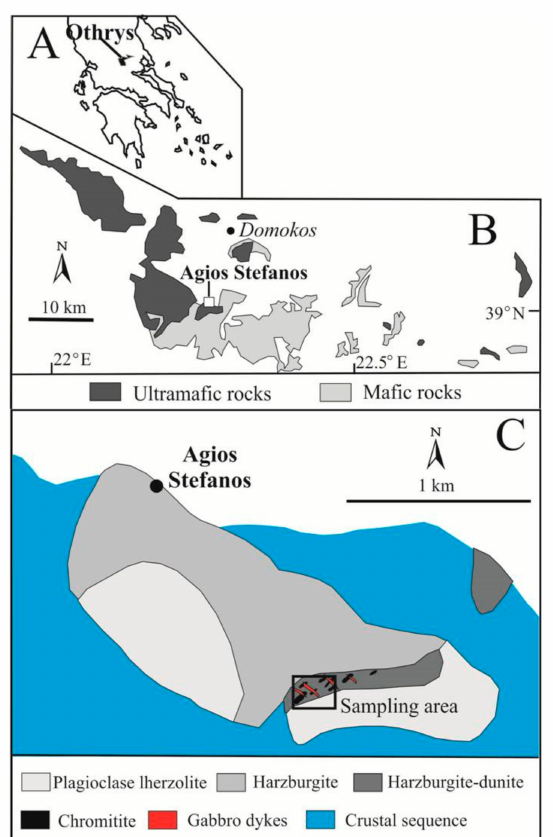
Figure 1. Location of the Othrys complex in Greece: ( A ) general geological map of the Othrys ophiolite showing the location of the Agios Stefanos chromium mine; ( B ) and ( C ) detailed geological setting of the Agios Stefanos area (modified after